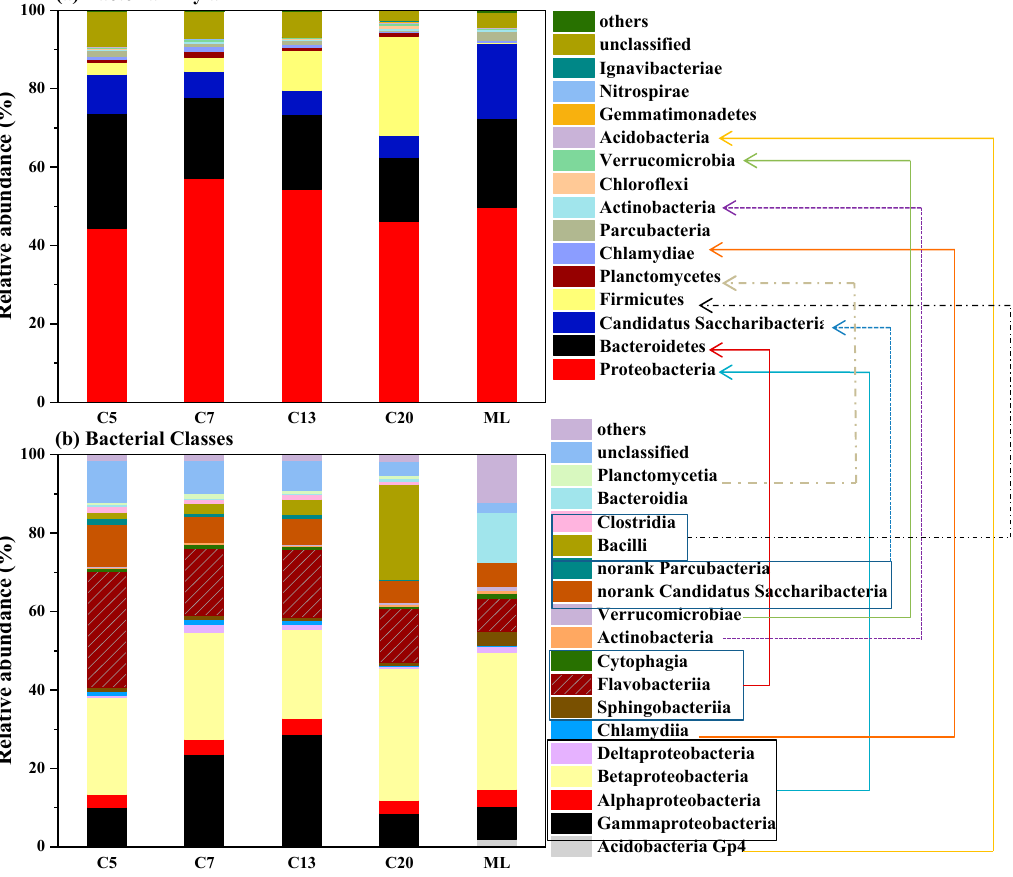
Figure 11. The relative abundance of the microbial community at the phylum level ( a ) and class level ( b ). (the arrows represent the bacterial classes belong to the corresponding bacterial phyla)